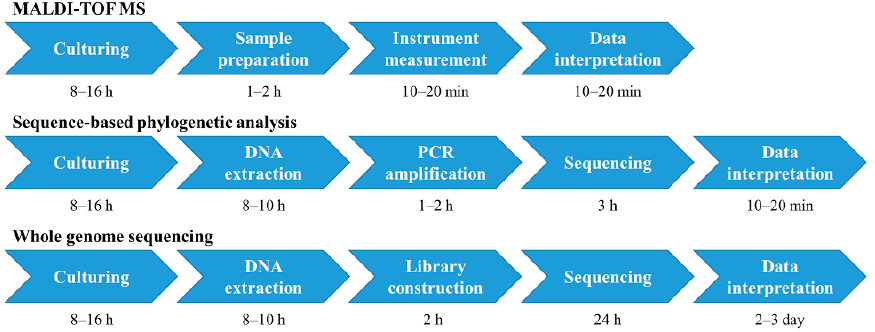
Figure 3. Procedures and time requirements in different methods. The time cost was calculated based on the preparation of 96 samples.